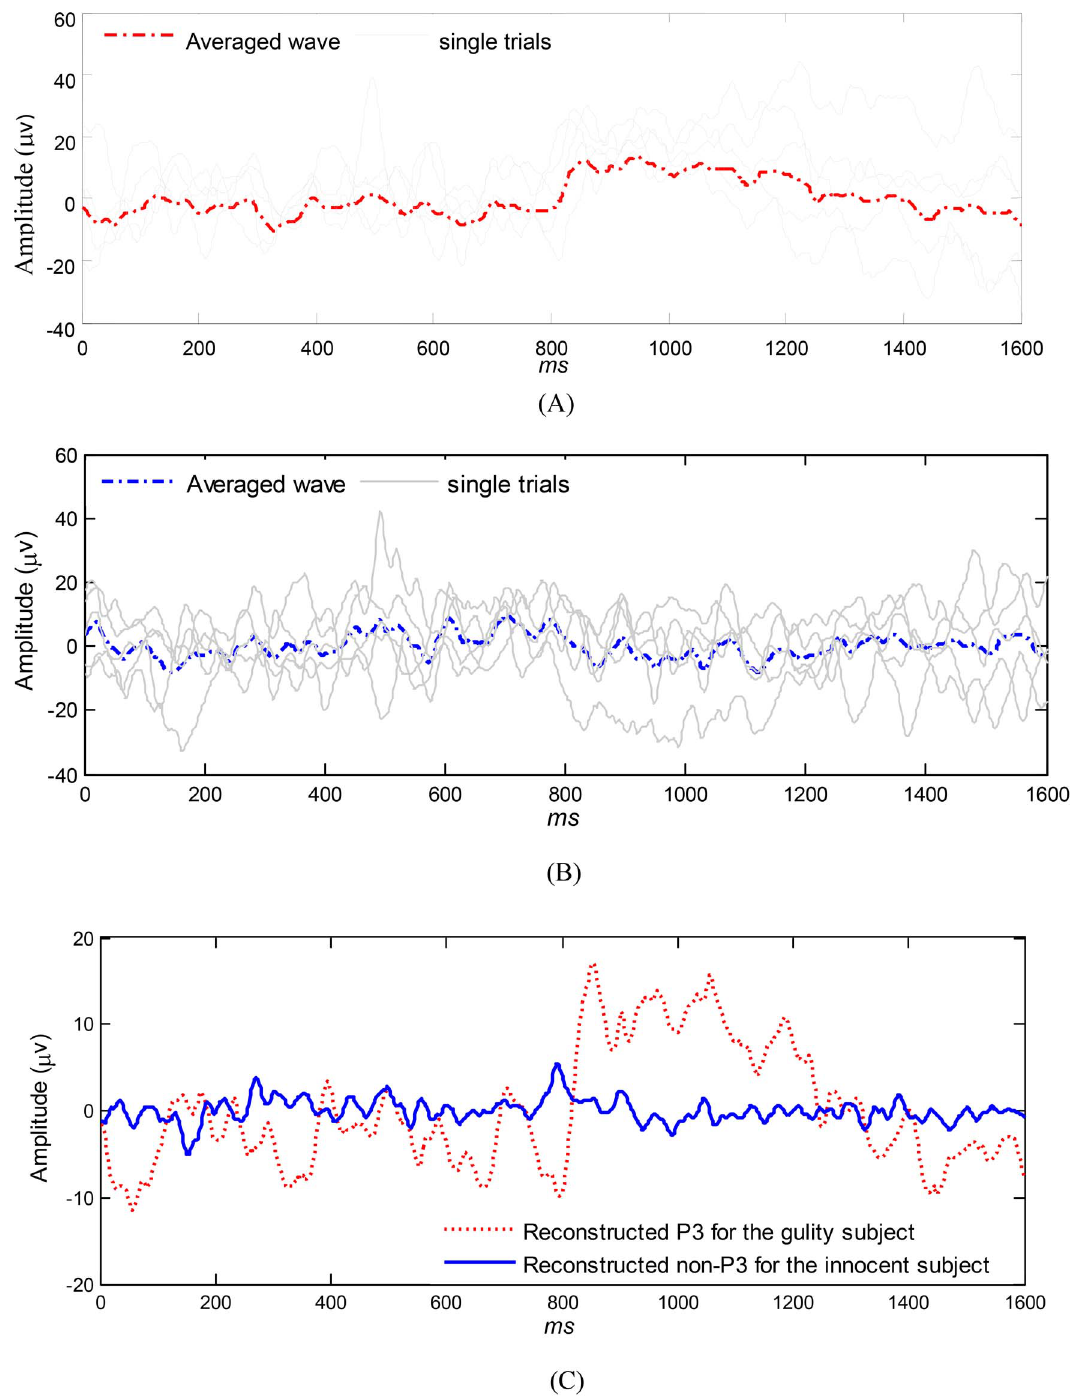
Figure 7. Response waveforms and reconstructed waveforms on Pz after applying SDA for a guilty and an innocent subject. 7A: Single trials (solid lines) and averaged waveform (dashed line) on Pz for a guilty subject before applying SDA. 7B: Single trials (solid lines) and averaged waveform (dashed line) on Pz for a guilty subject before applying SDA. 7C: Reconstructed waveforms (a P300 for the guilty subject and a non-P300 for the innocent subject) by applying SDA on the averaged